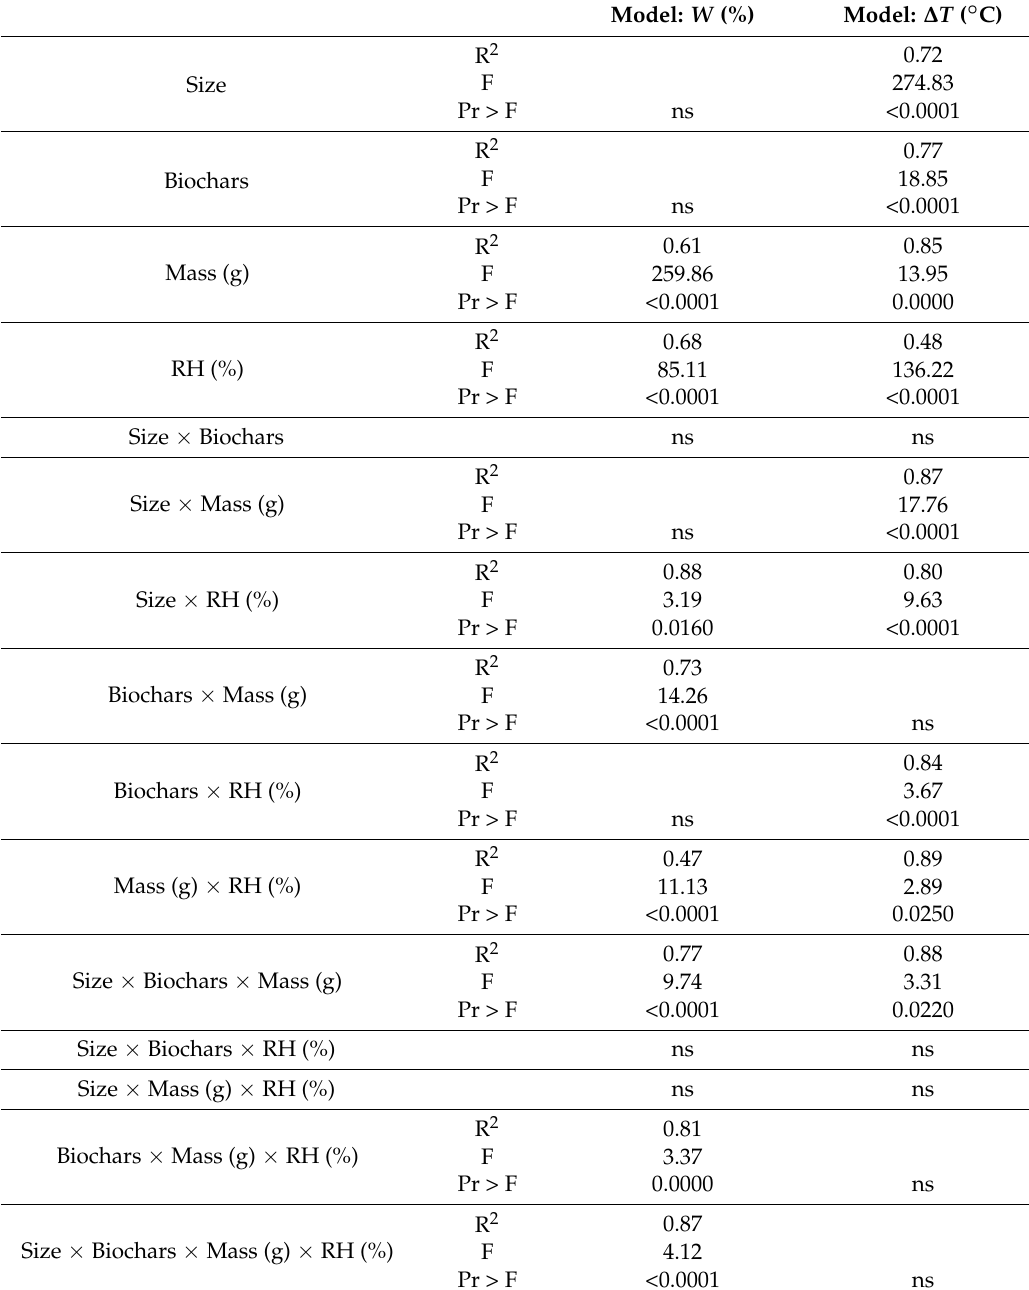
Table 7. Statistics synthesis for explanatory variables and their interactions. R 2 values are cumulated. p -values < 0.0001 = significant; ns = not